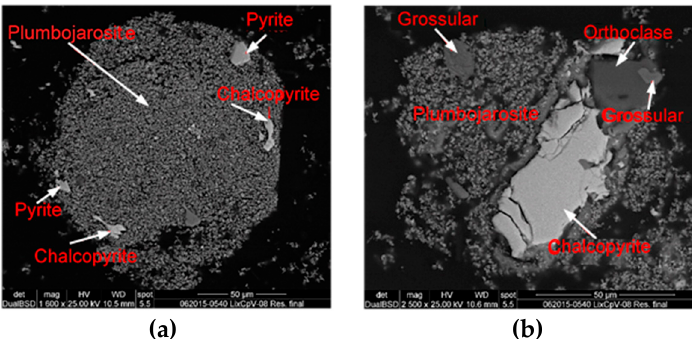
Figure 12. Precipitation of plumbojarosite under low acidity conditions during leaching. ( a ) Plumbojarosite particle, ( b ) unreacted chalcopyrite particle.